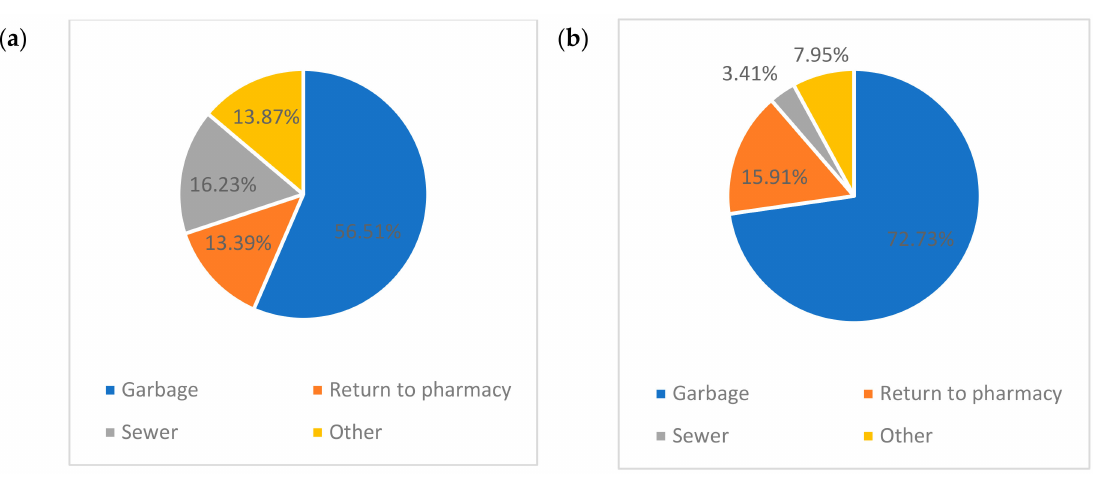
Figure 2. ( a ) Disposal methods according to our local survey. ( b ) The average of the disposal methods according to the results recorded in the 48 reviewed